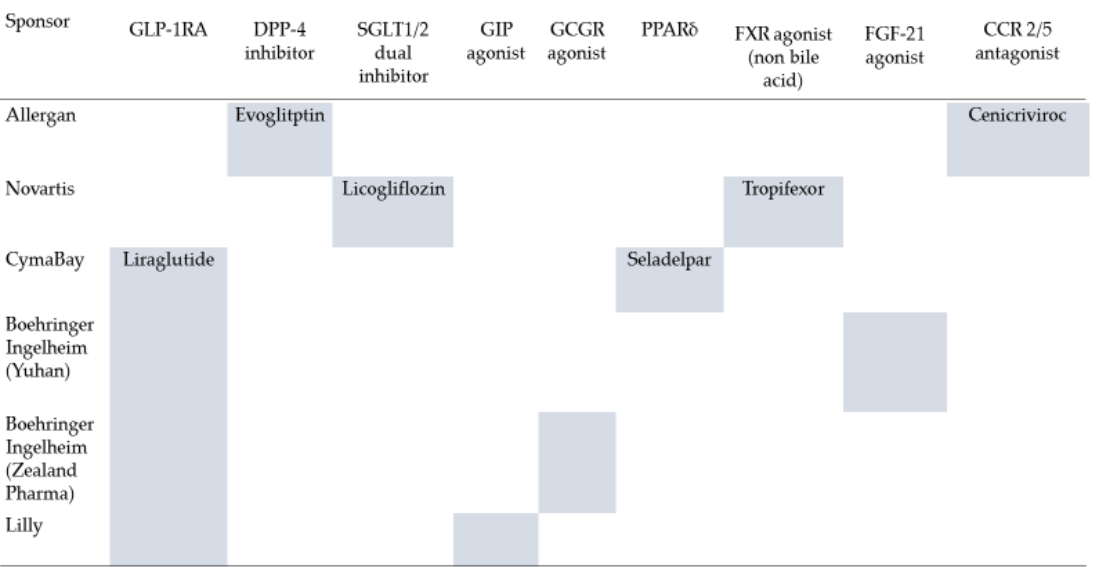
Figure 3. Drug pipelines of NASH “Combo” , including antidiabetic drugs. GLP-1RA: glucagon-like peptide receptor agonist, DPP-4: dipeptidyl peptidase-4, SGLT: sodium-glucose cotransporter, GIP: gastrointestinal peptide, GCGR: glucagon receptor, PPAR: peroxisome proliferator-activated receptor, FXR: farnesoid X receptor, FGF-21: fibroblast growth factor-21, CCR2/5: C-C motif chemokine receptor-2/5.